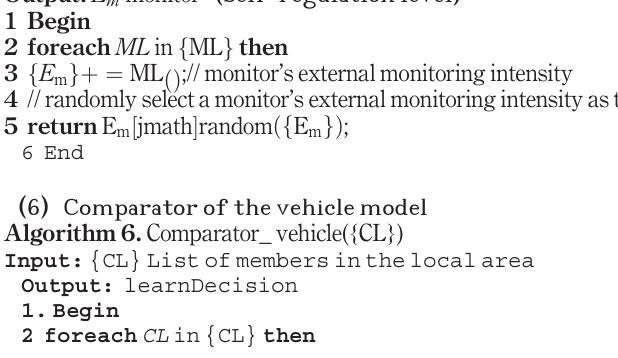
Algorithm 6. Comparator_